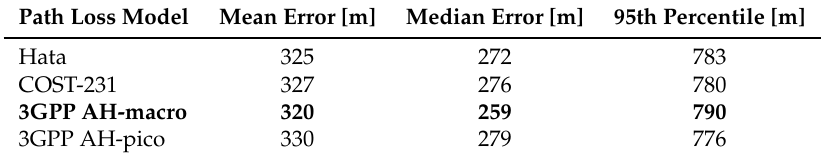
Table 1. Location estimation errors for different urban path loss models of an RSS-based ranging algorithm using a single NB-IoT antenna and cell sector.